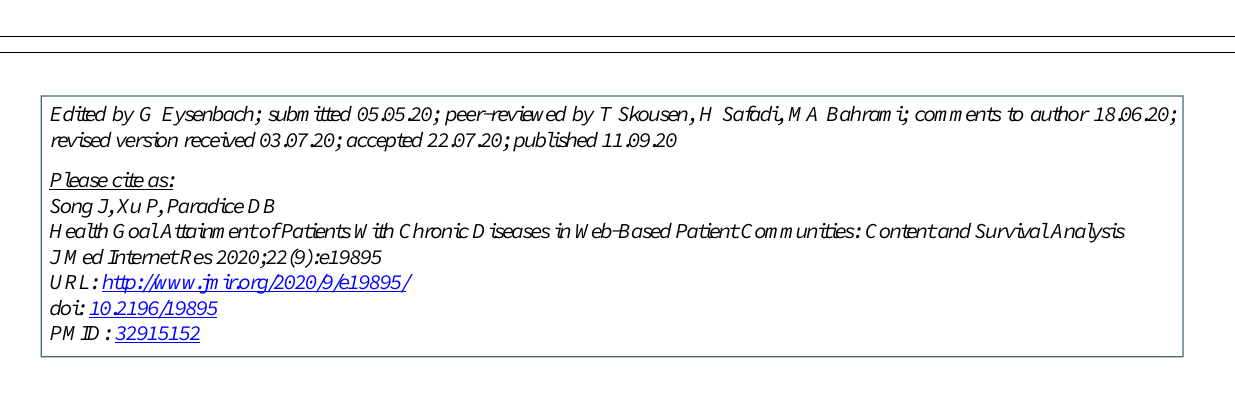
VIF: variance inflation